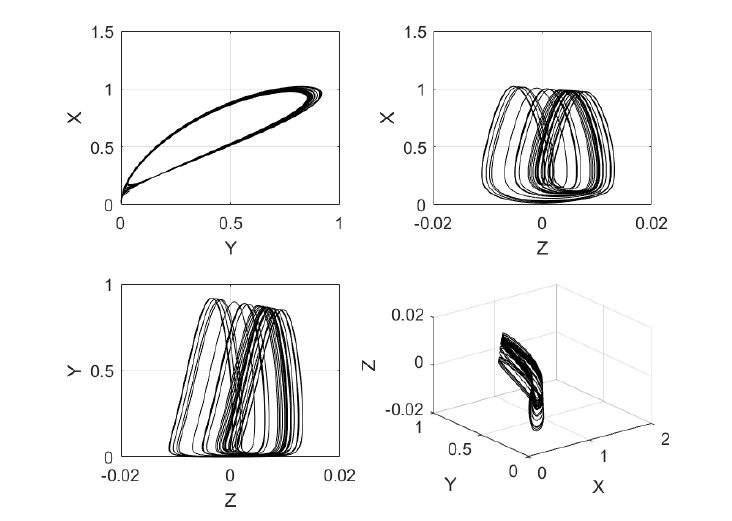
Figure 4. Phase-space portraits of the Hindmarsh–Rose neuron given in Equation (5), using x 0 = 0.1169282607, y 0 = 0.03563851071, and z 0 = 0.01034665217, as initial